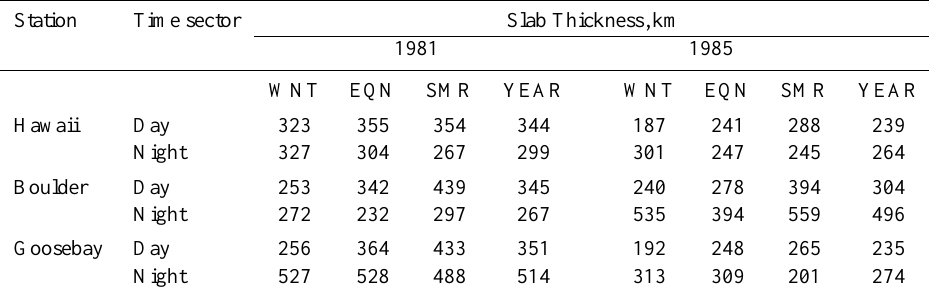
Table 2. Mean daytime (08:00–16:00LT) and night-time (20:00–04:00LT) values of ionospheric slab thickness, in km, for magnetically quiet days during the solar maximum phase 1981 and the solar minimum phase 1985 for the stations of Hawaii, Boulder and Goosbay for three seasons (WNT – winter, EQN – equinox, SMR – summer) and annual mean (YEAR).